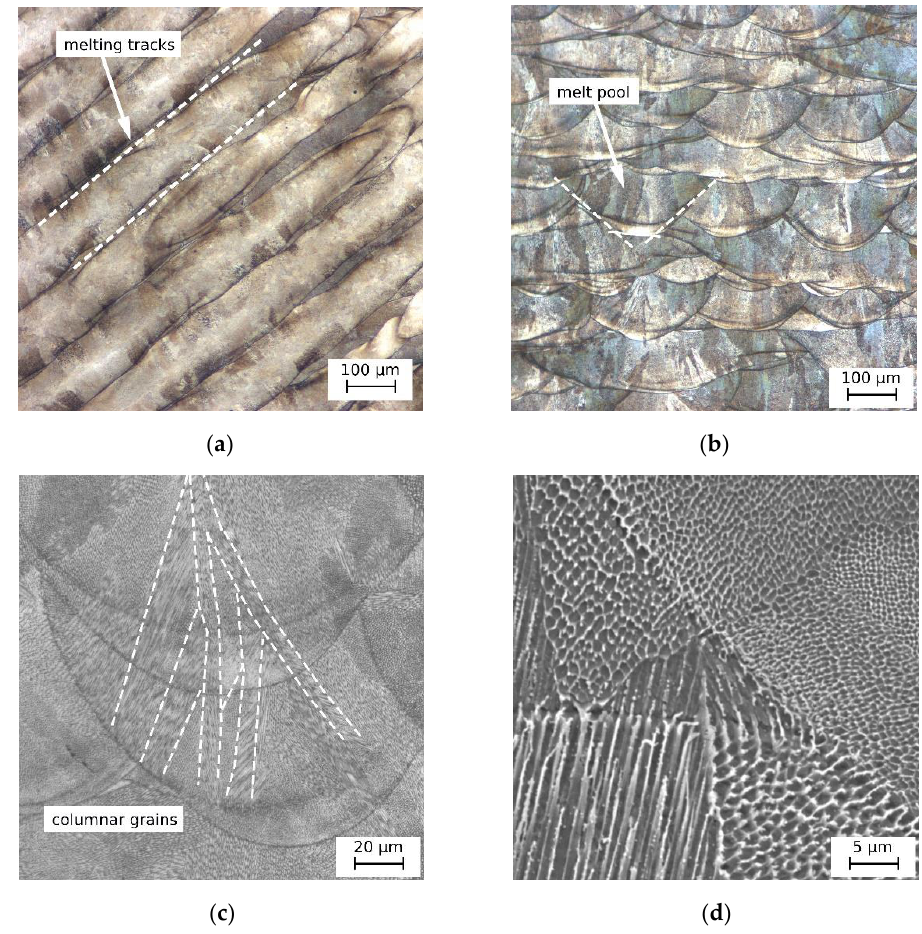
Figure 1. Initial microstructure of the 3D-printed Co-Cr-Mo alloy: ( a ) XY section (optical microscopy (OM) micrograph; ( b , c ) XZ section (OM); ( d ) scanning electron microscopy (SEM) micrograph.